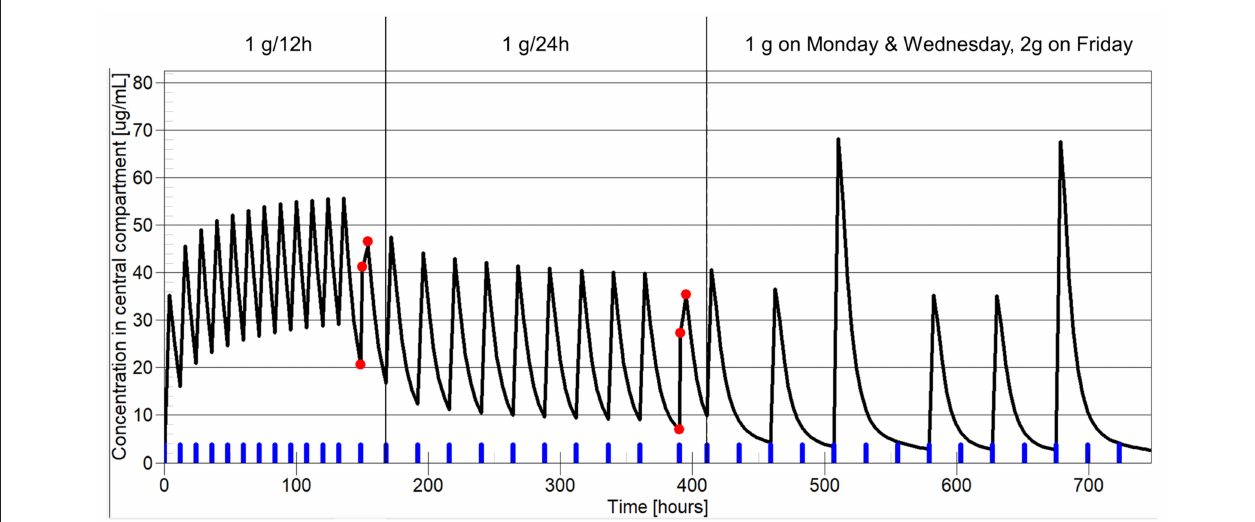
FIGURE 2 | Example of dosage individualization based on pharmacokinetic/pharmacodynamic (PK/PD) in patient #4, treated with suppressive ceftazidime for persistent P. aeruginosa PJI. The x -axis shows the time, the y -axis represents ceftazidime plasma concentration. Of note, this is not the real time of drug therapy. The time scale has been altered to show the three dosage periods on the same plot. The blue marks on the x -axis show drug administrations. The red dots represent the patient-measured ceftazidime concentrations. The black line represents model prediction. The vertical line separates the three dosage periods: 1 g/12h, 1 g/24h, and 1g on Monday and Wednesday + 2g on Friday. On the first TDM occasion, under a dosage of 1 g/12h, the measured ceftazidime C min was 20.7 mg/l, well above the target concentration of 10 mg/l (5 × MIC) for this patient. The model predicted that a dosage of 1 g/24h would result in C min of 8.2 mg/l and 88% of time above the target level. The dosage was adjusted as suggested. TDM was performed a second time, 2 months later, under a dosage of 1 g/24h. The measured ceftazidime C min was 7 mg/l, in good agreement with the model prediction 2 months before. The model predicted that a dosage of 1g on Monday and Wednesday and 2g on Friday would result in C min of 2.7 mg/l and 40% of time spent above the target level of 10 mg/l (5 ×